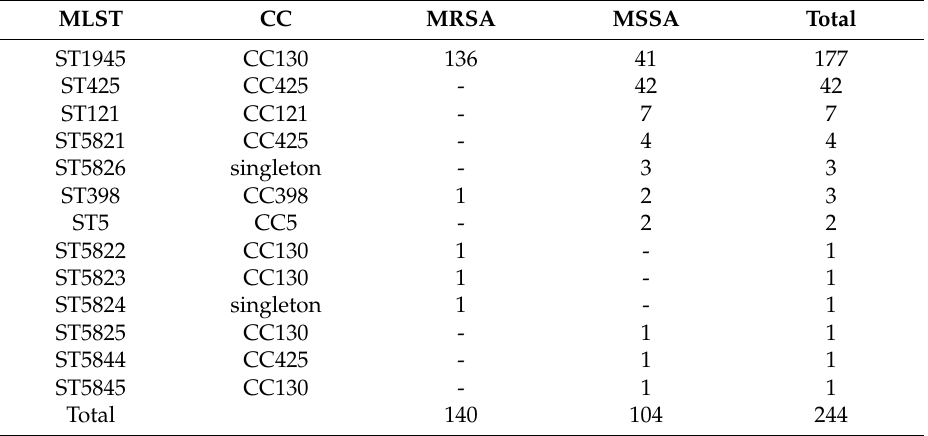
Table 4. Correlation between MLST and the clonal complexes of the studied isolates.